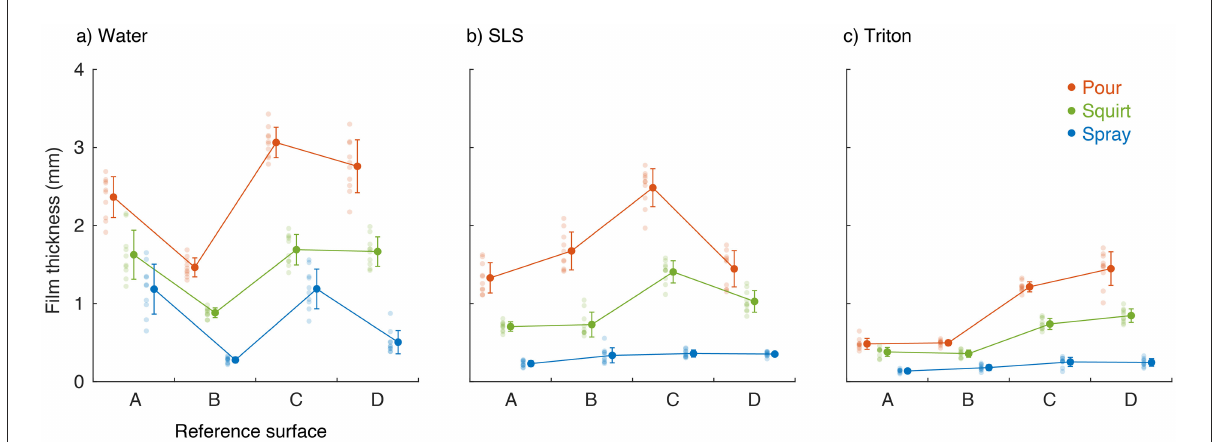
FIGURE3 Raw data and mean ± SD of the natural film thickness for the three application methods (pour, squirt, and spray) on the four reference surfaces (A, B, C, D) for the three contaminants: (a) distilled water, (b) 0.05% SLS solution, and (c) 0.04% Triton solution.